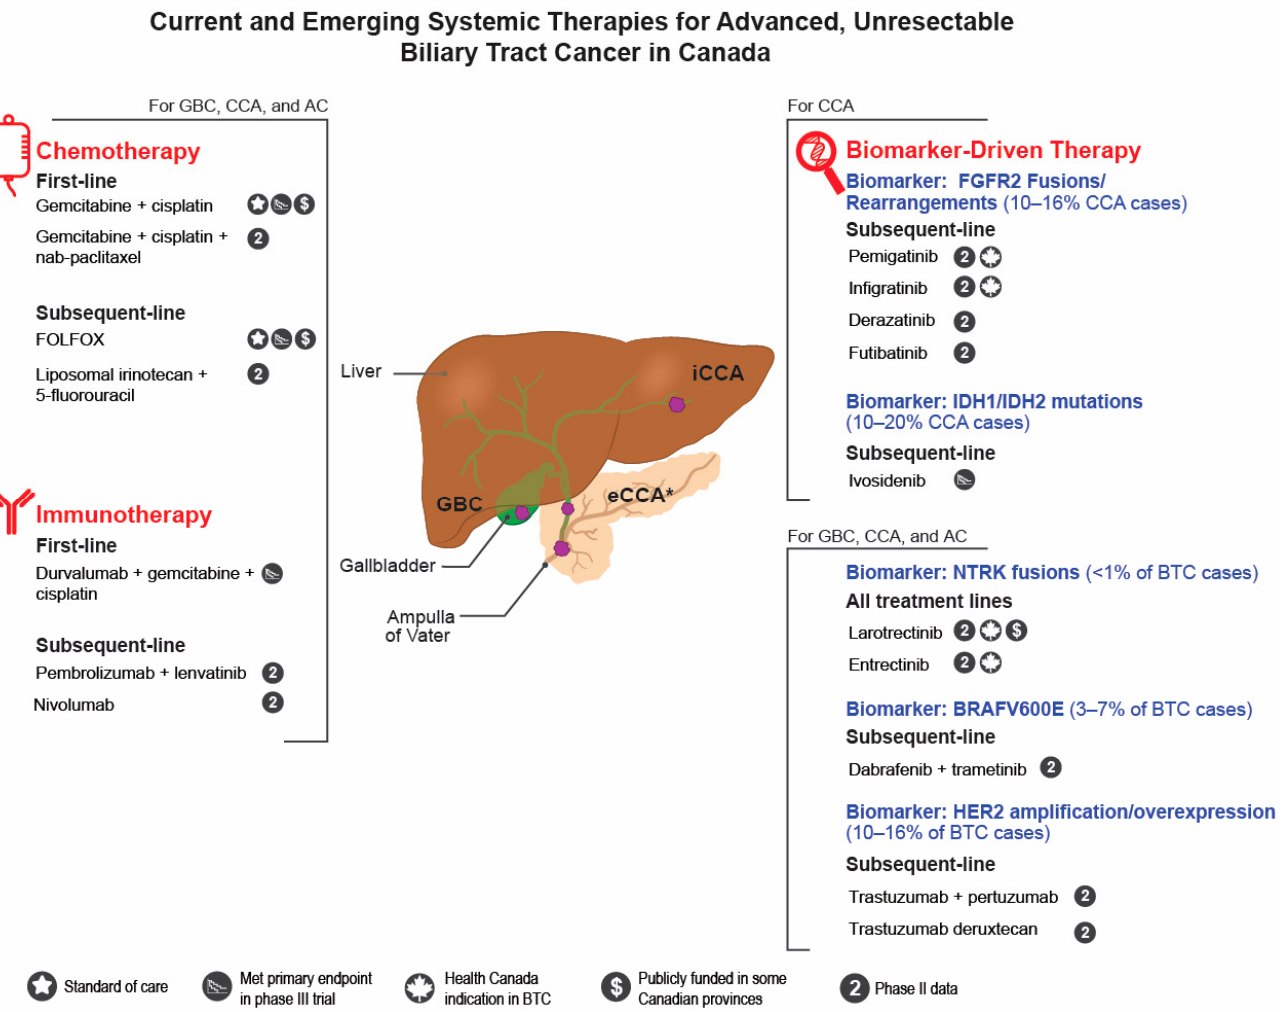
Figure 1. Current and emerging systemic therapies for advanced, unresectable biliary tract cancer in Canada. AC, Ampullary cancer; BTC, biliary tract cancer; CCA, cholangiocarcinoma; eCCA, extrahepatic cholangiocarcinoma; GBC, gallbladder cancer; iCCA, intrahepatic cholangiocarcinoma. *eCCA can be further subdivded into perihilar CCA which is proximal to the origin of the cystic duct and distal CCA which occurs between the cyctic duct and Ampulla of Vater.